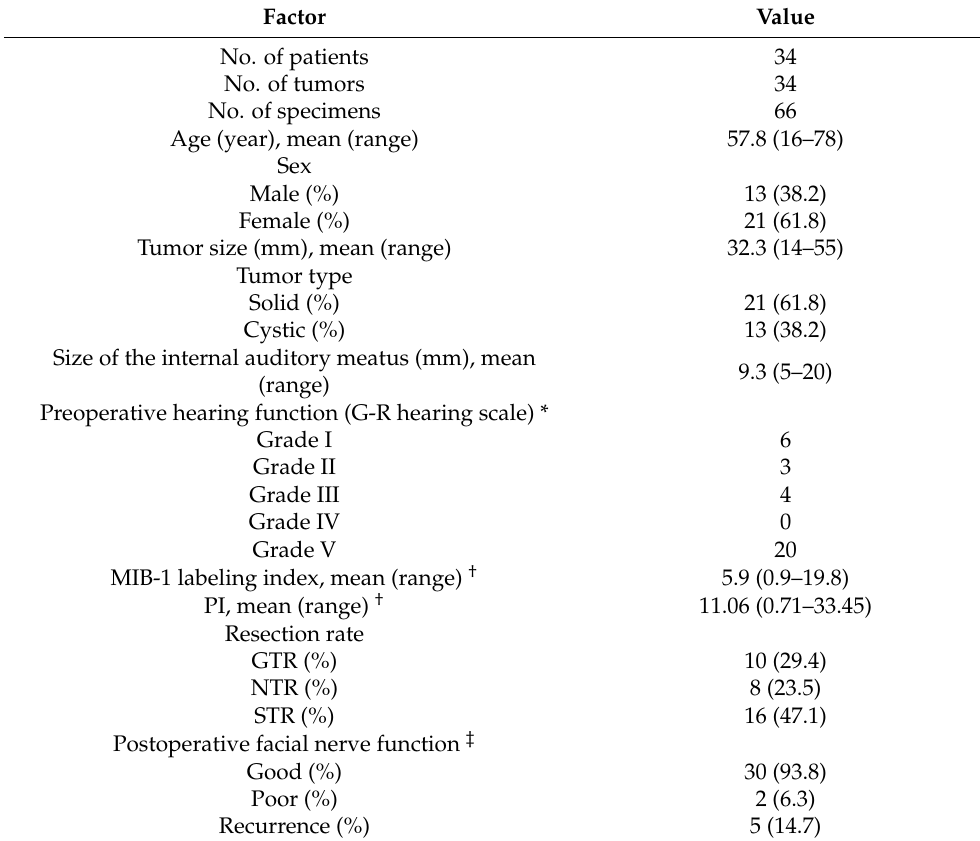
Table 1. Patient demographics and characteristics of